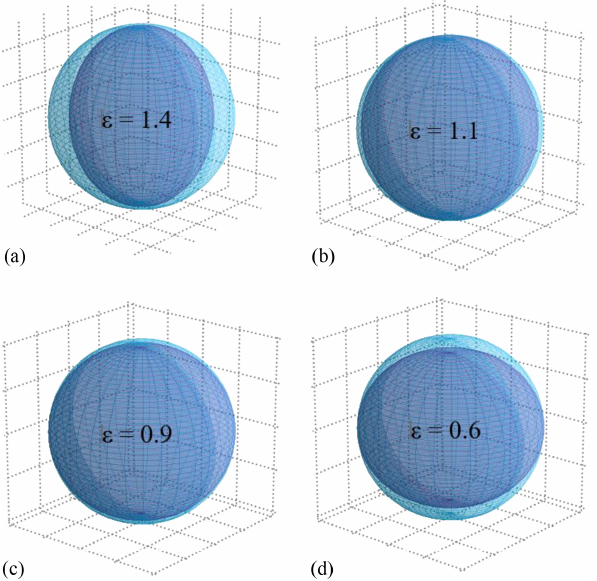
Figure 2. Examples of spheroids used (in dark blue colour), em- bedded in a perfectly spherical shell (in light blue colour), to visual- ize their deviation from the perfect sphere. (a, b) Prolate spheroids with (a) ε = 1 . 4 and (b) ε = 1 . 1, and (c, d) oblate spheroids with (c) ε = 0 . 9 and (d) ε = 0 . 6.